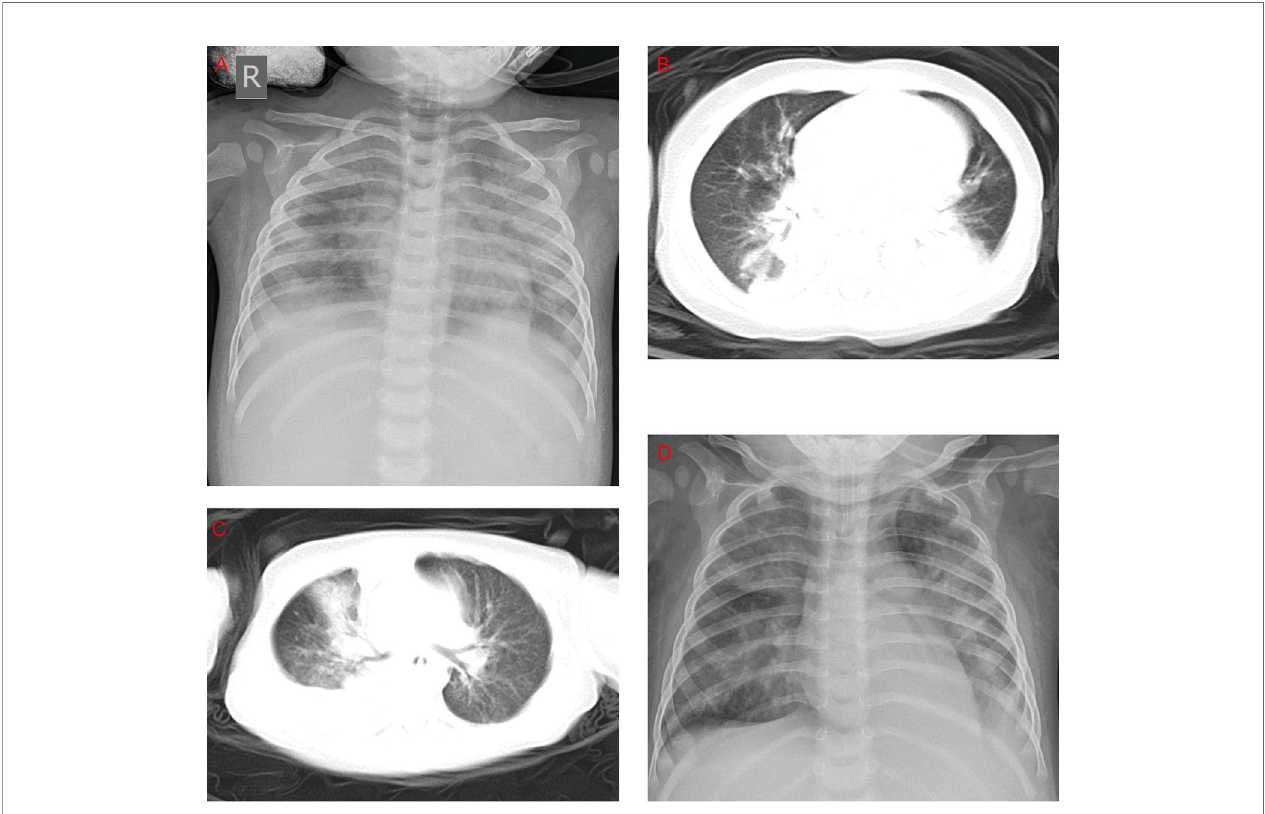
FIGURE 3 | Chest x-rays and chest CTs of patients. (A) Chest x-ray of a 1-year-old boy. The brightness of both lungs was diffusely decreased, showing a large area of patchy shadow with uneven density. Tracheal intubation was seen in the trachea and the heart shadow outline was not cl ear. (B) Chest CT of a 9-month-old boy: mass shadows of high density in both lungs. Bright bronchogram is seen in the lung tissue area of the lesion, which is also called bronchoin fl ation sign. Condensation shadows were mainly on the lower right lobe. (C) Chest CT of a 11-month-old girl. Condensation shadows were mainly on the right lobe, with right pleural effusion. (D) Chest x-ray of a 10-month-old boy. Patchy blurred shadow was seen in both lungs, the left diaphragm and costal phrenic angle disappeared. Tracheal intubation was seen in the trachea and the heart shadow outline was